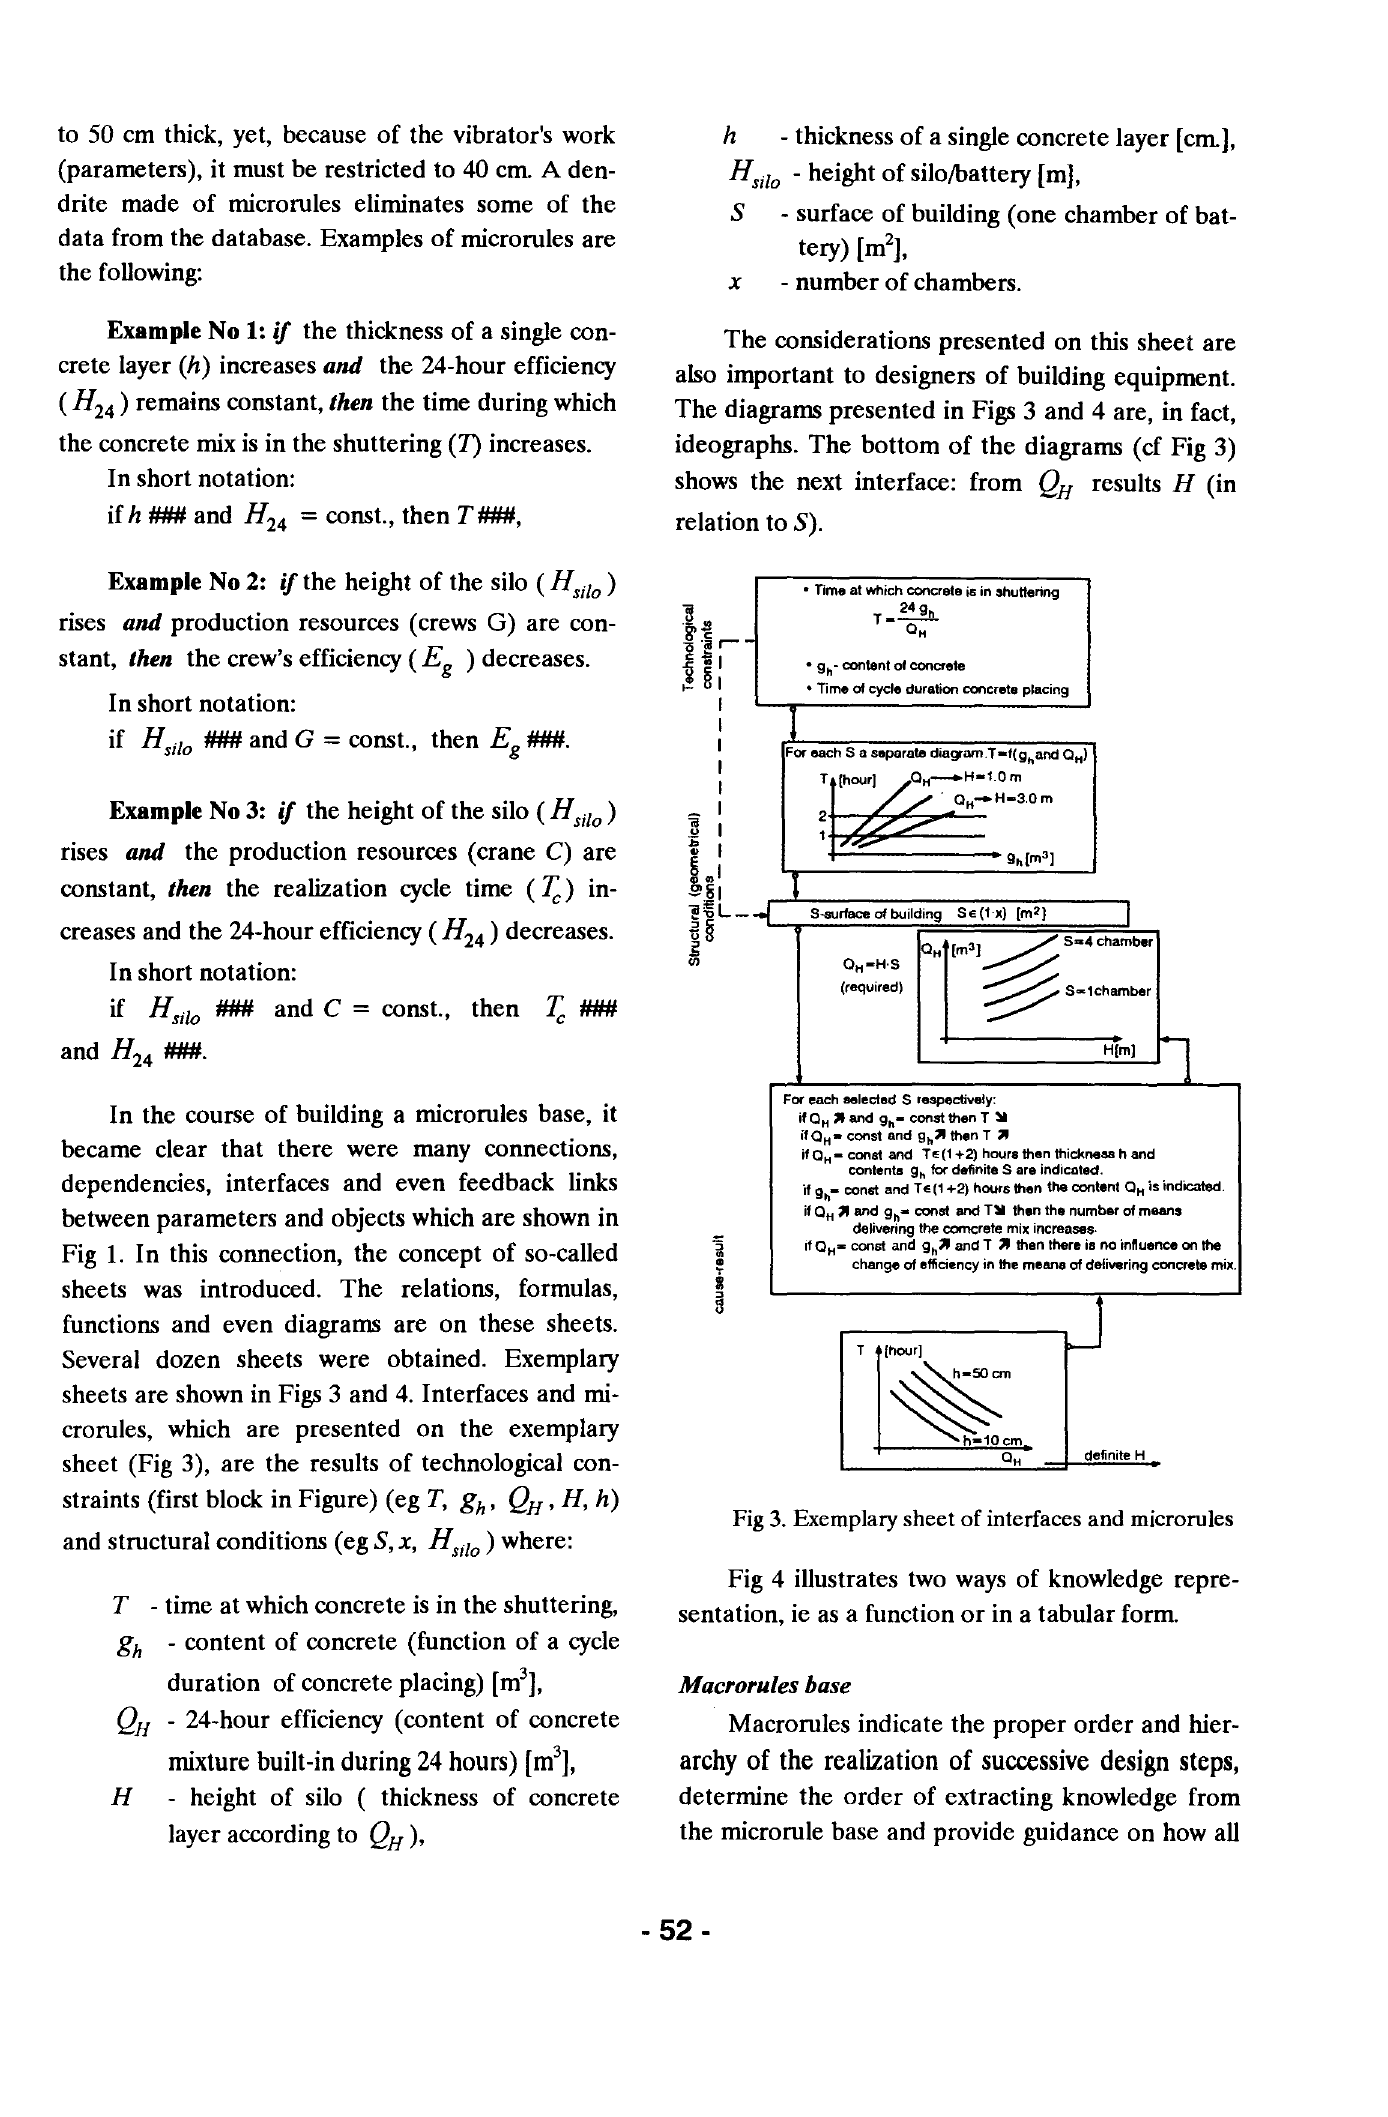
Fig 3. Exemplary sheet of interfaces and